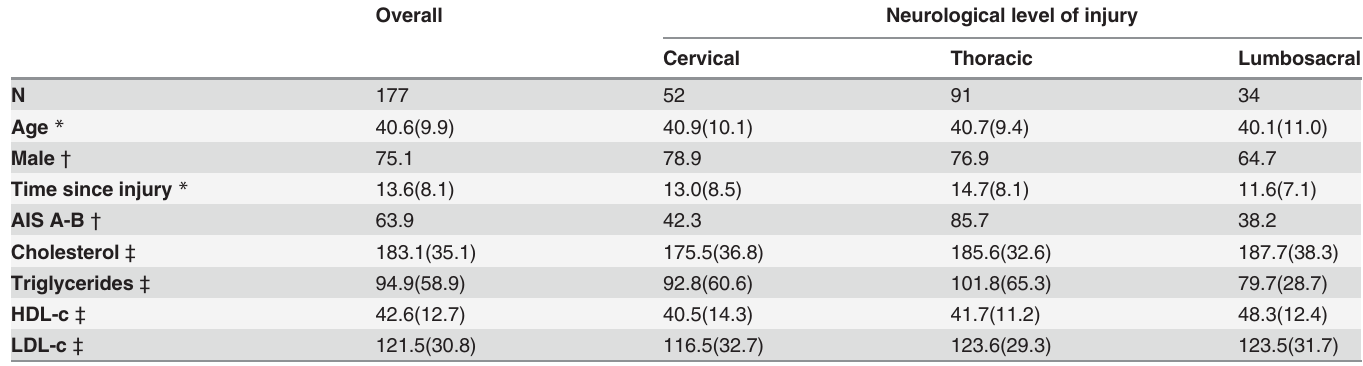
Table 1. Sample characteristics.